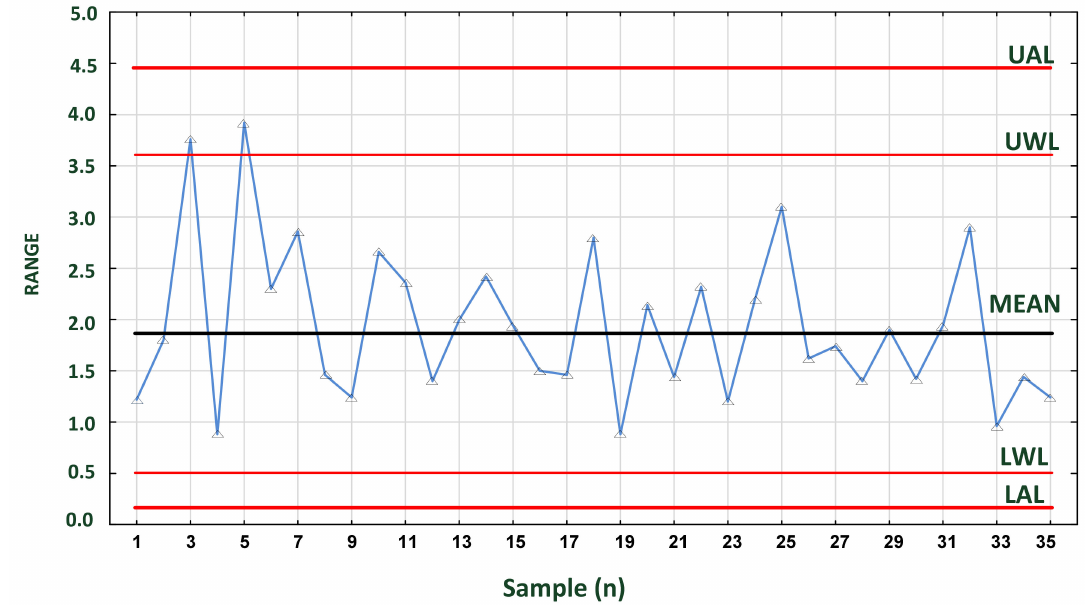
Figure 9. Range control chart for samples of 4 temperatures measured in a container at 2 h intervals. Source: own data. Abbreviations: as in Figure 8.